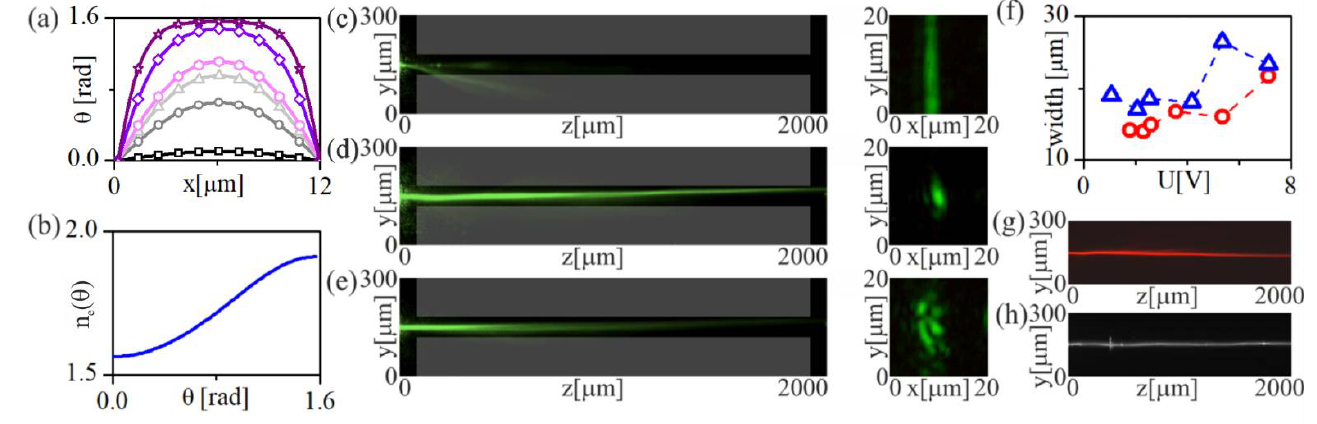
Figure 3. ( a ) Director distribution in NLC cell along the x -axis (cell thickness) as a function of the voltage (solid lines), plotted for U = 1.2 V—black (square), 1.5 V—gray (circle), 2.0 V—light gray (triangle), 2.5 V—magenta (hexagon), 7.0 V—violet (diamond), and 20.0 V—purple (star). ( b ) Refractive index for TM-polarized beam (λ = 532 nm) as a function of the orientation of molecules. ( c – e ) Experimental evidence of a (1D + 1) waveguide formation (electrode width 5 μm) and propagation of TM-polarized beam at λ = 532 nm. Beam evolution in yz-plane (left panel) and corresponding output profiles in xy -plane (right panel) ( c ) for U = 0 V, ( d ) for U = 2.3 V, and ( e ) for U = 7.0 V biasing voltage. ( f ) Mean beam width plotted for different voltages for 5 μm (red circles) and 10 μm (blue triangles) electrode widths. ( g ) Propagation of a TM-polarized beam at λ = 642 nm and ( h ) λ = 1064 nm, for U = 1.8 V and 5 μm electrode width.